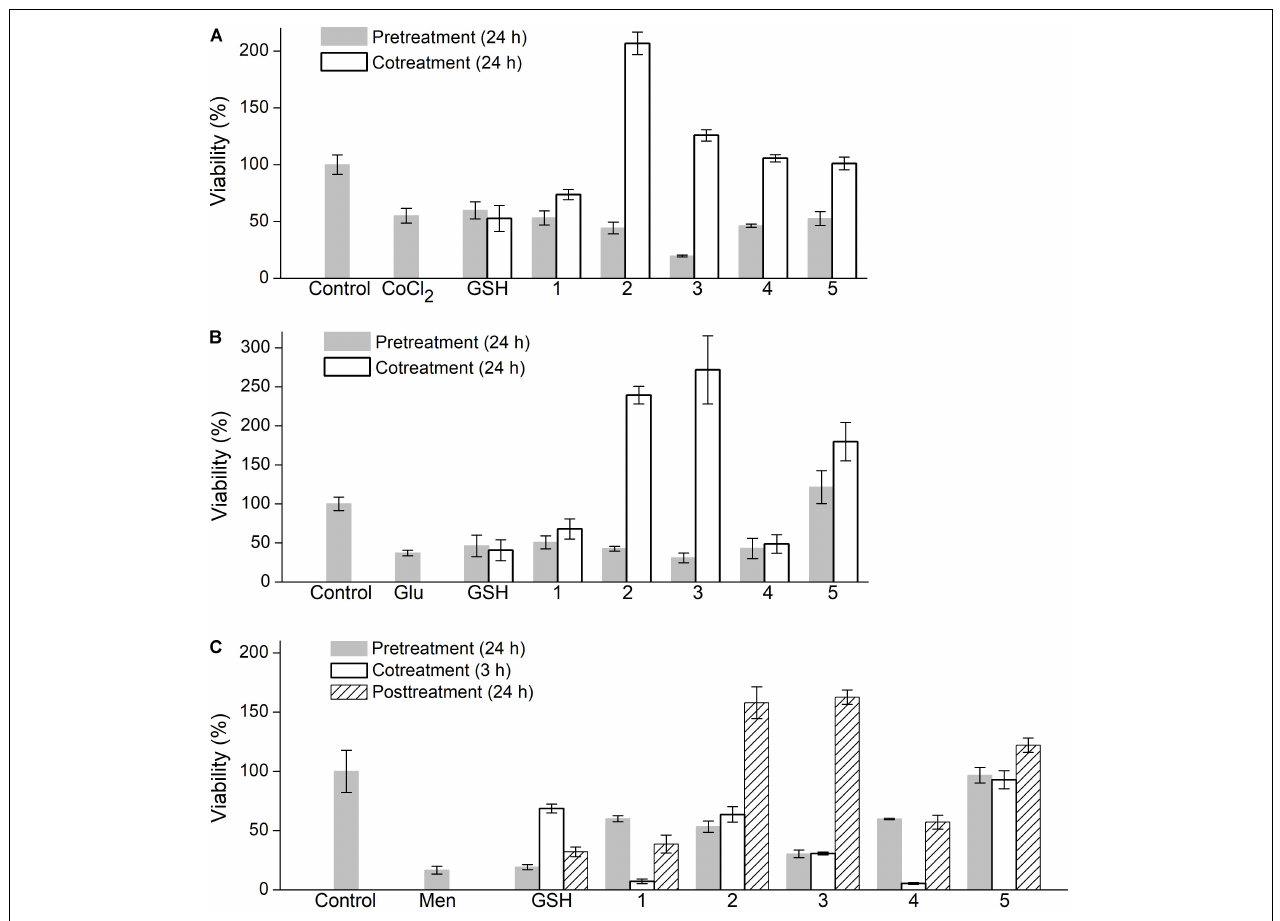
FIGURE 5 | Effect of oligopeptides on viability of PC-12 cells subjected to oxidative factors (A) cobalt chloride (CoCl 2 ), (B) L -glutamic acid (Glu), (C) menadione (Men). Concentration of oligopeptides and GSH 5 mM, CoCl 2 2.5 mM, Glu 50 mM, Men 25 µ M. Oligopeptides were supplemented to medium (FBS-free α -MEM) prior to factors (‘pretreatment’), together with factors (‘cotreatment’) or following factors (‘posttreatment’). Cell viability was evaluated by MTS assay. Mean ± SD are shown ( n =